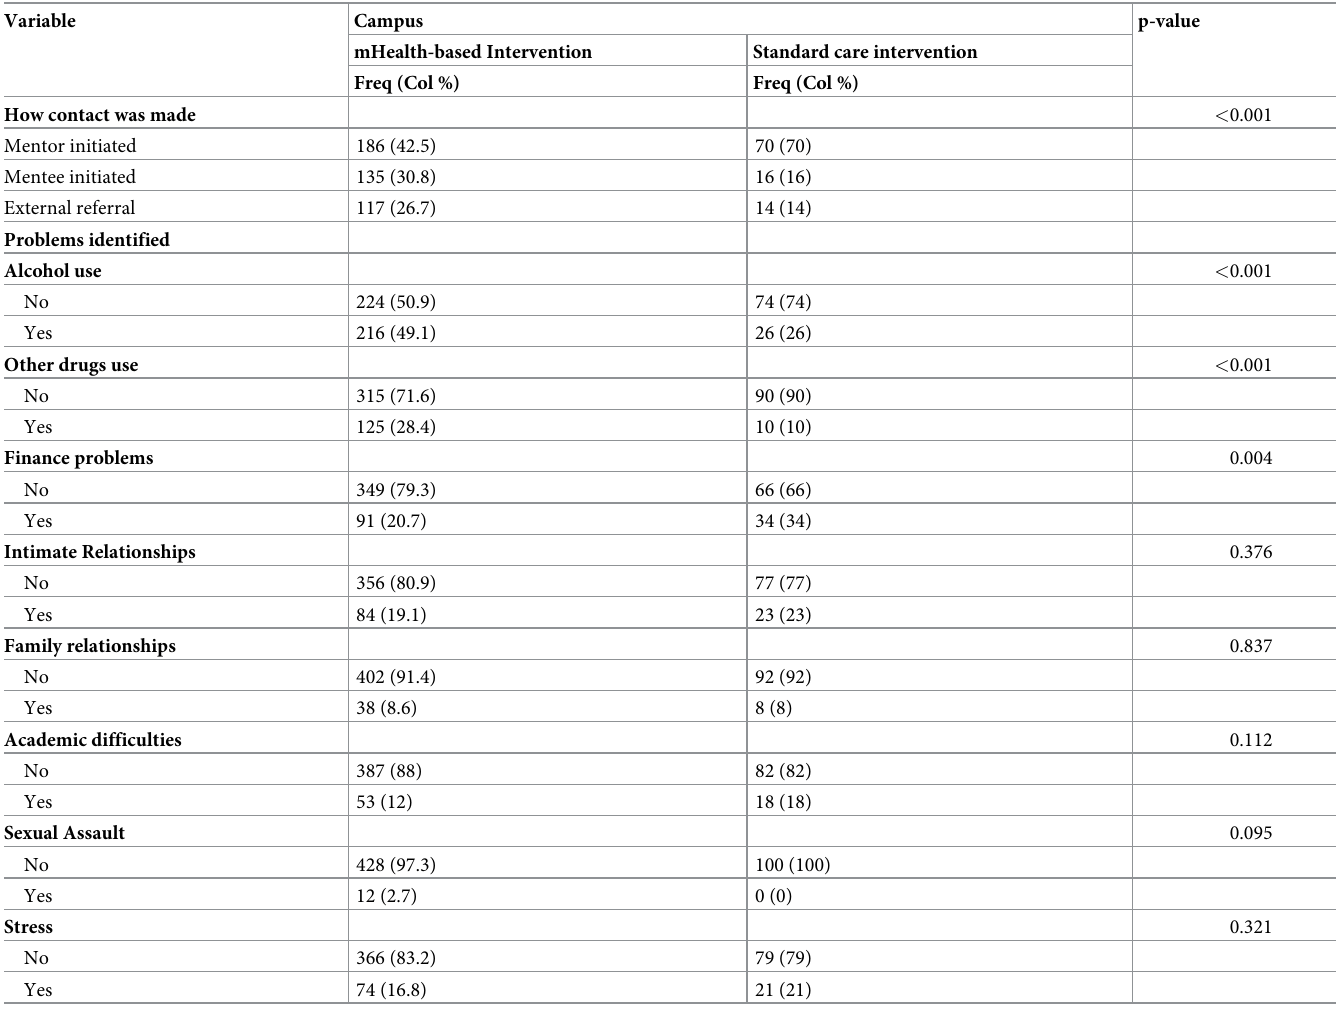
Table 4. Contacts made and the problems as identified by the peer